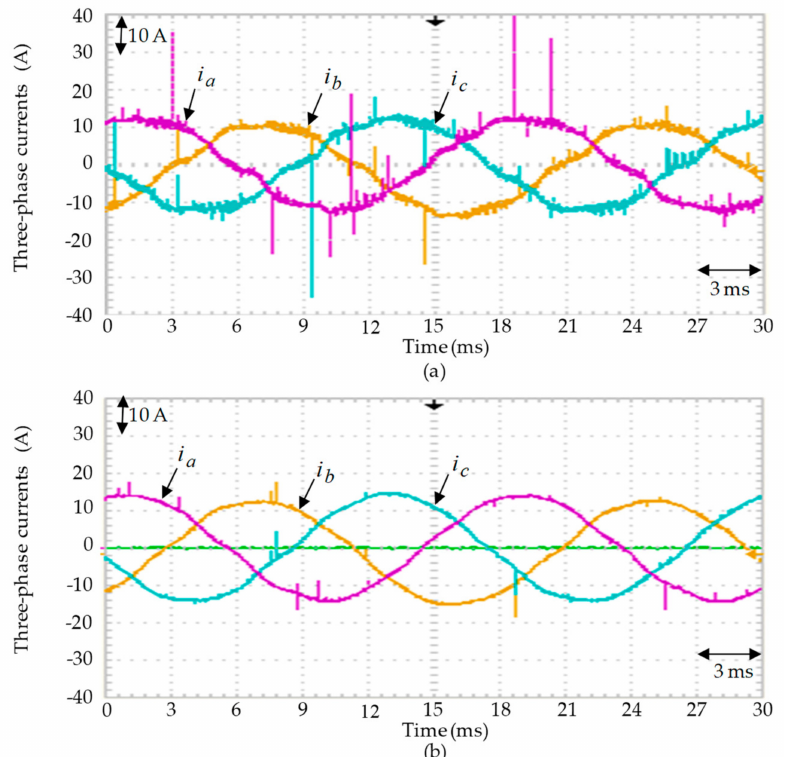
Figure 12. Responses of three-phase currents via experimental results for the ISM driving the rice milling machine system at test JA by adopting the controllers: ( a ) TA; ( b ) TB.